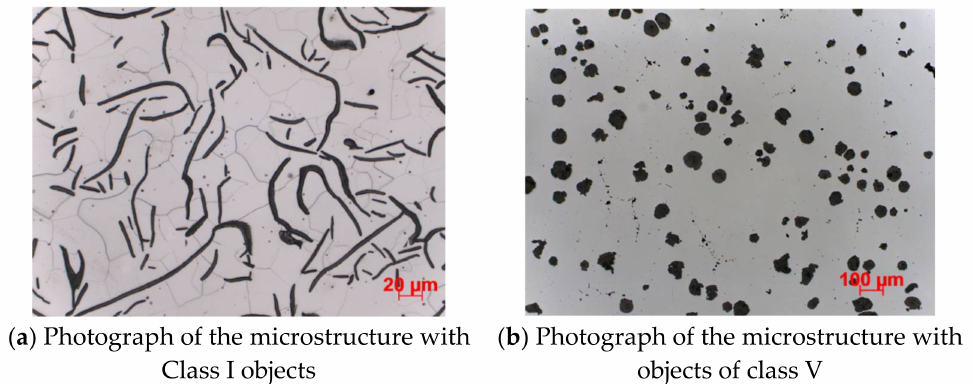
Figure 7. Two sample photos of microstructures. Their textures and shapes in this location are radically different. It’s important for used artificial intelligence methods.